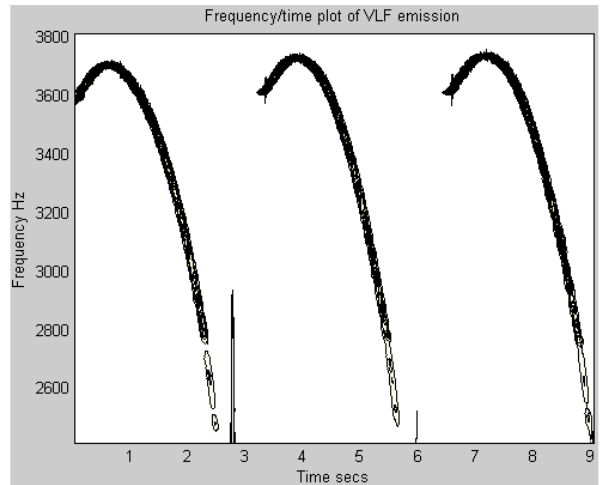
Fig. 16. Simulated falling frequency chorus sequence spectrogram for a cold plasma density of Ne=191 electrons/cc, which closely corresponds to the data presented by Macusova et al. (2007). The high linear growth rate used of 220dB/s favours faller generation since the wave profile is driven upstream. The initial upward hook is not seen in the observations, and sweep rates ∼− 1.1kHz/s are at the lower end of those